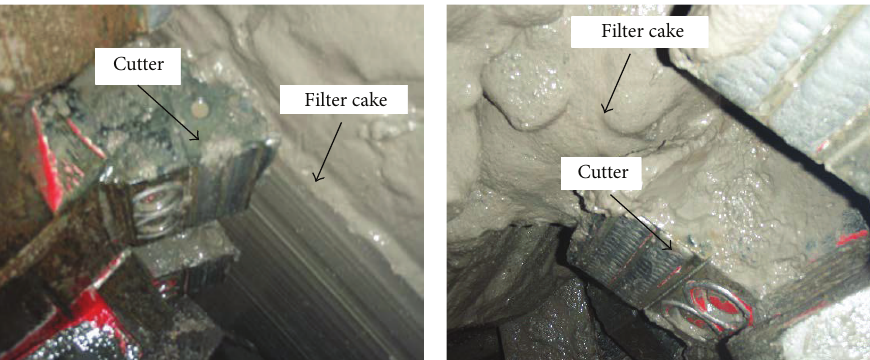
Figure 9: Photos of the filter cake screened in the excavation chamber.